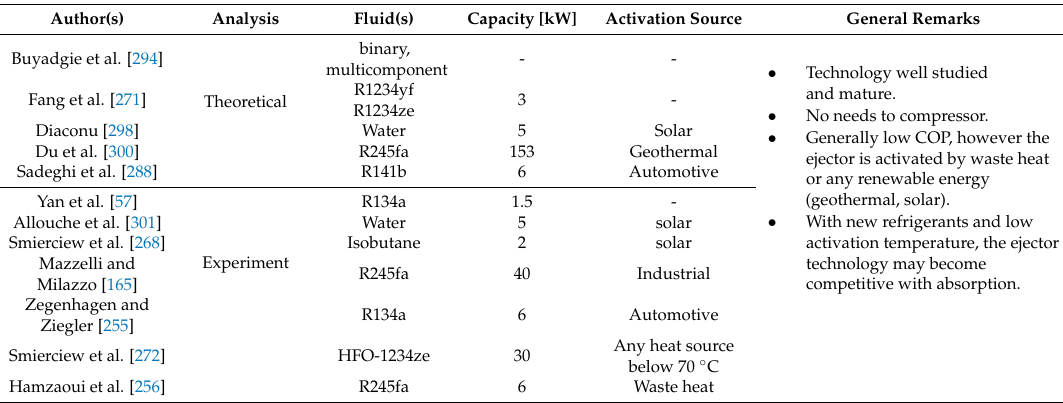
Table 6. Selected ERS